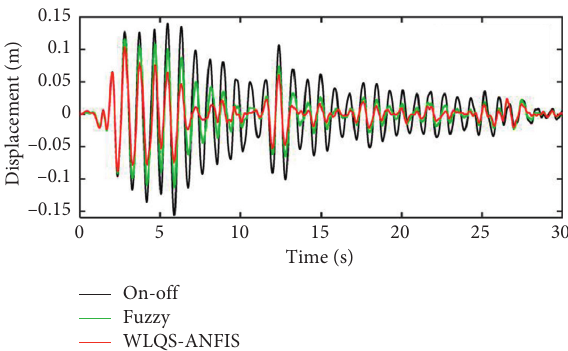
Figure 18: The top floor displacement responses with different control methods.